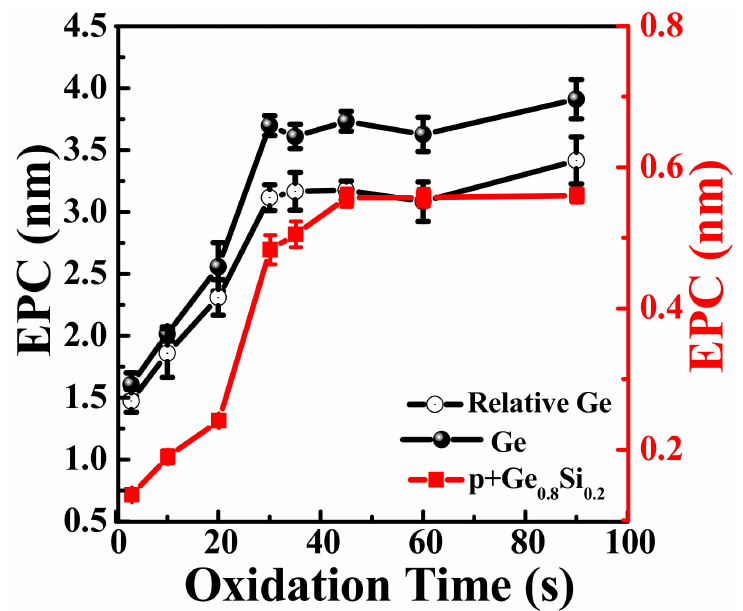
Figure 4. EPCs of ALE with different oxidation time for Ge and p + -Ge 0.8 Si 0.2 (100) planes and Ge selectively etched in p + -Ge 0.8 Si 0.2 /Ge stacks. (30 cycles; Temperature of HNO 3 = 20 ◦ C; Experimental data of average values and error bars are shown in the